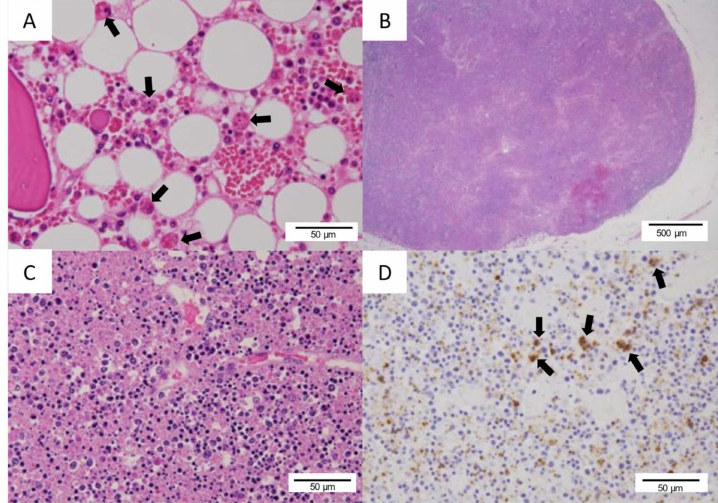
Figure 4. Histological findings: ( A ) arrows indicate hemophagocytosis in the bone marrow (hematoxylin–eosin stain, magnification: × 100); ( B ) the inguinal lymph node was necrotizing and lost normal architecture (hematoxylin–eosin stain, magnification: × 40); ( C ) necrotizing lymphadenitis with infiltration of histiocytes and large-sized blastoid cells (hematoxylin–eosin stain, magnifica- tion: × 100); ( D ) arrows indicate severe fever with thrombocytopenia syndrome virus–nucleoprotein (SFTSV–NP) positive cells found in the lymph node (immunohistochemistry for SFTSV–NP antigen, magnification: ×